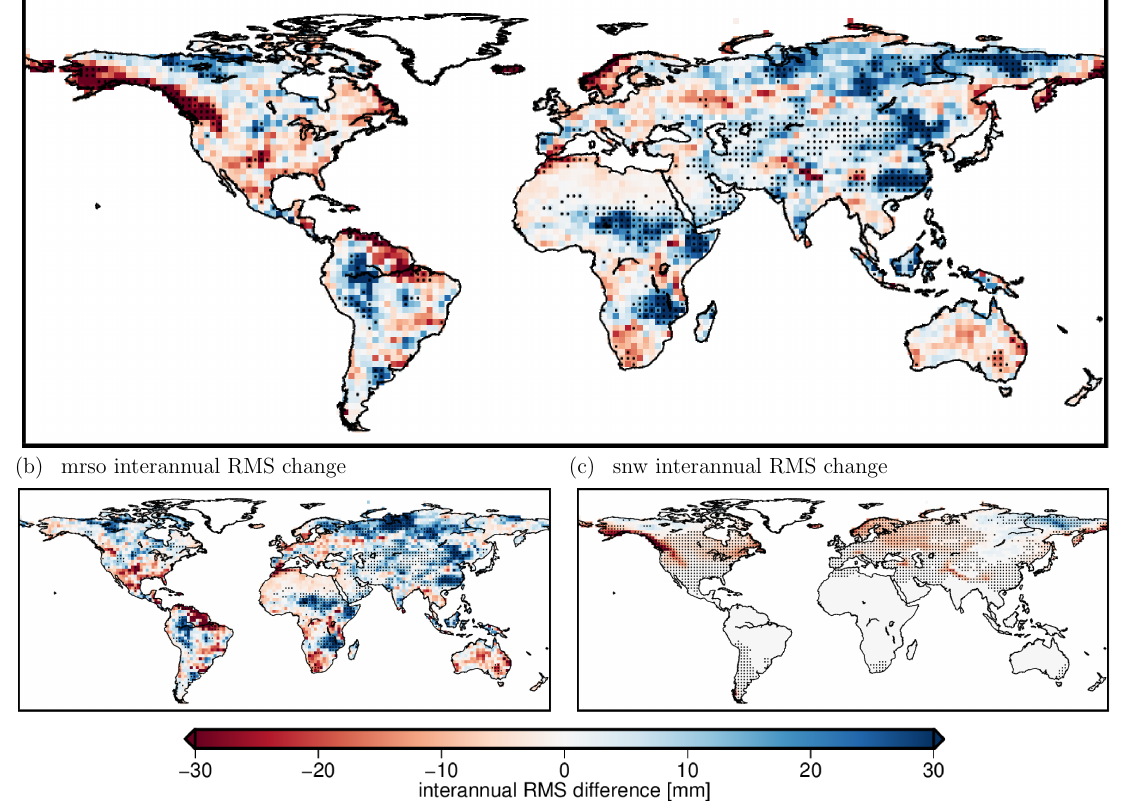
Figure 9. ( a ) MMMed mTWS interannual RMS change from 2002–2020 to 2082–2100. Stippling indicates regions where 13 or more of 17 models (i.e., ≥ 76%) agree on the sign of the RMS change. ( b , c ) same as ( a ) but for mrso and